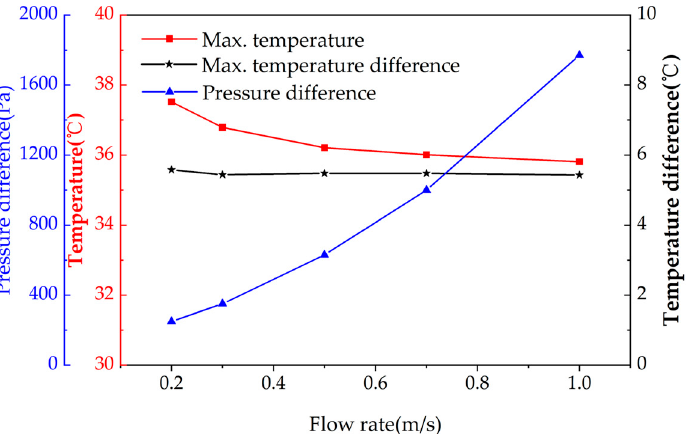
Figure 7. The change in maximum temperature, maximum temperature di ff erence, and pressure di ff erence with di ff erent fl ow rates.